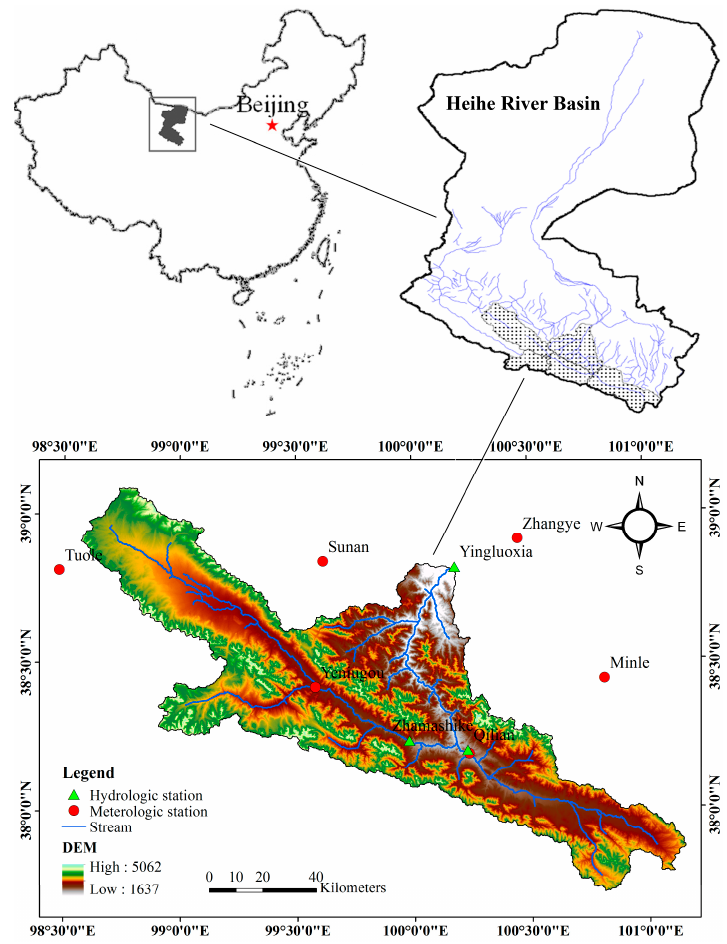
Figure 1. Upper reaches of the Heihe River Basin.